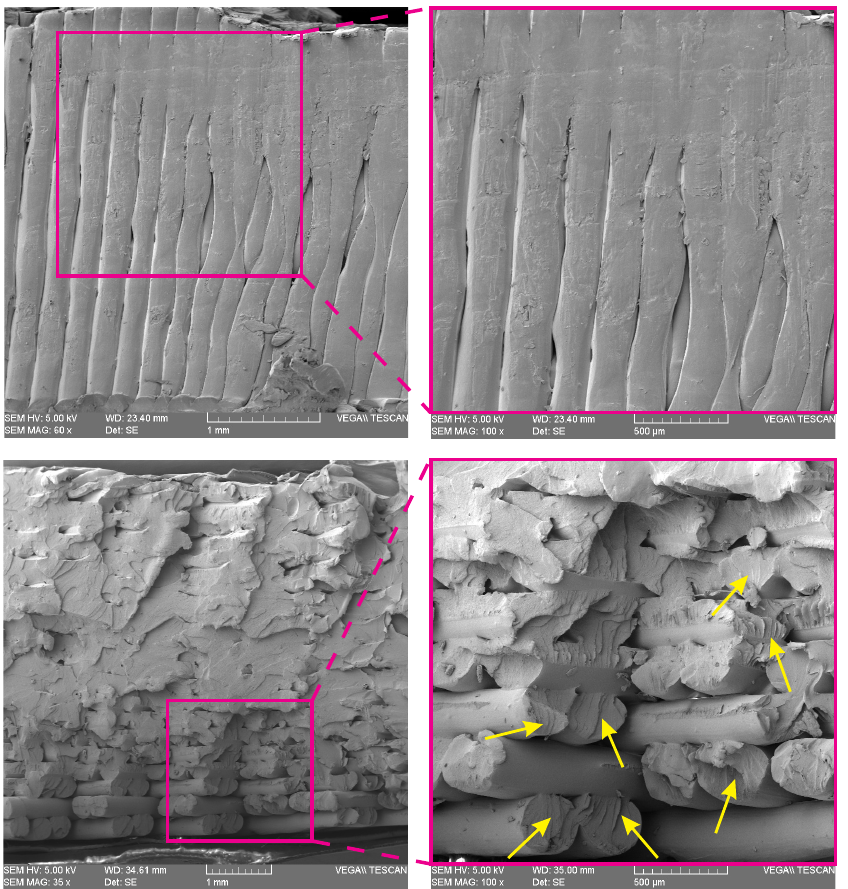
Figure 10. SEM images of point 2 ( top ) and point 3 ( bottom ) of a 3D-printed ABS specimen with hole diameter of 12